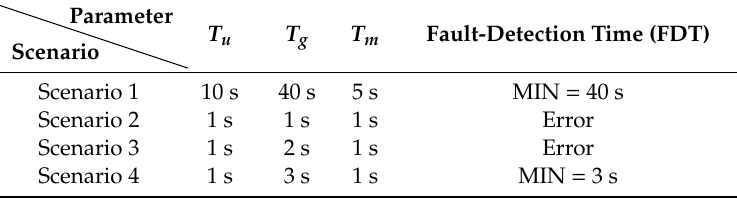
Table 4. Experimental results for Kubernetes parameter